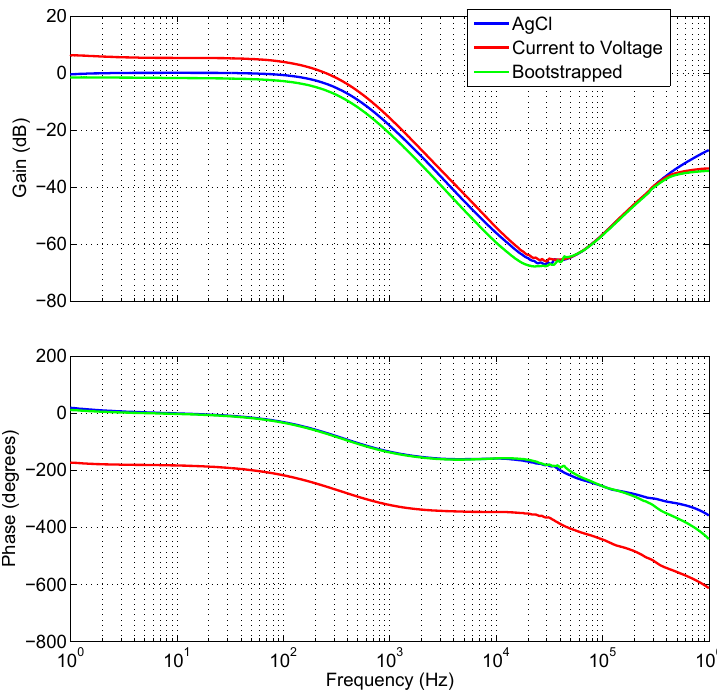
Figure 5. The gain and phase response of Ag/AgCl electrodes (blue) compared against the low impedance electrode (red) and high impedance